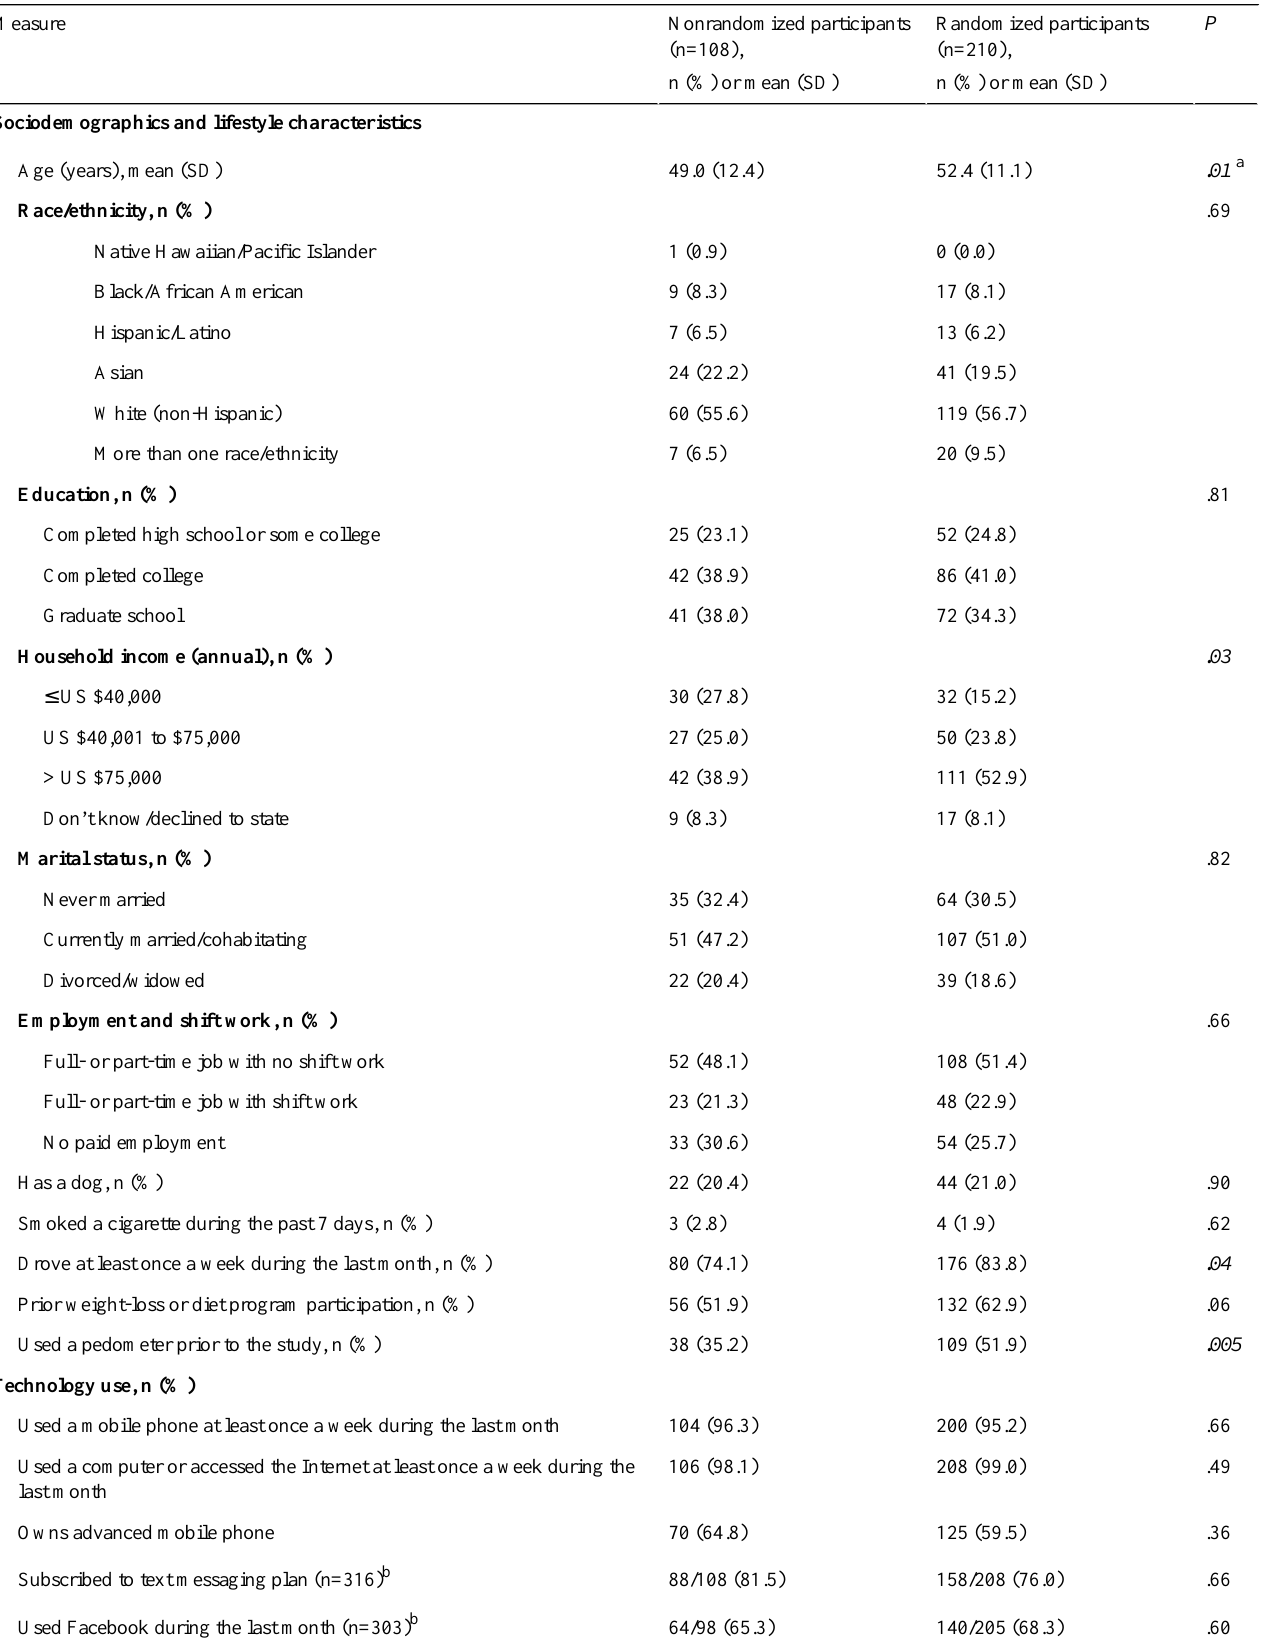
Table 1. Univariate comparisons of randomized and nonrandomized participants